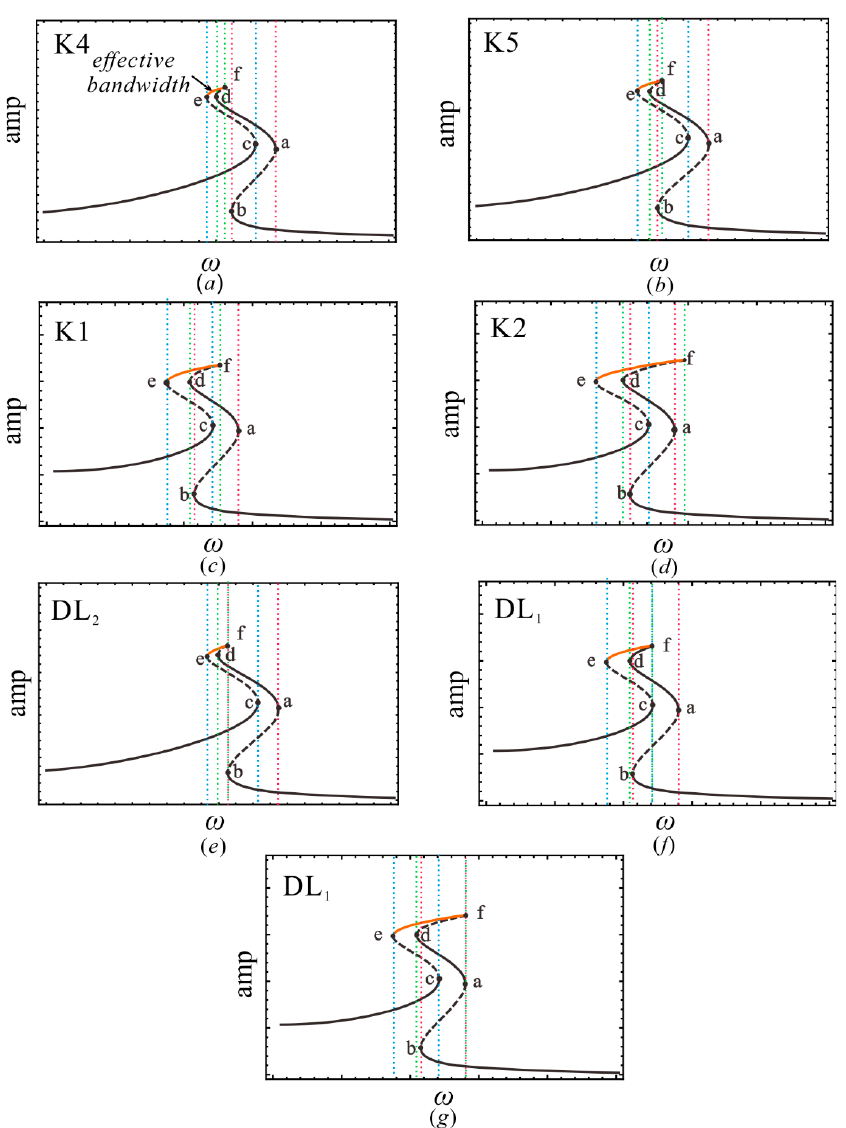
Figure 9. Amplitude–frequency response curve in ( a ) region K4; ( b ) region K5; ( c ) region K1; ( d ) region K2; ( e ) line DL 2 of K4–K5; ( f ) line DL 1 of K5–K2; ( g ) and line DL 1 of K2–K1, where the solid points a–f are tangent points.